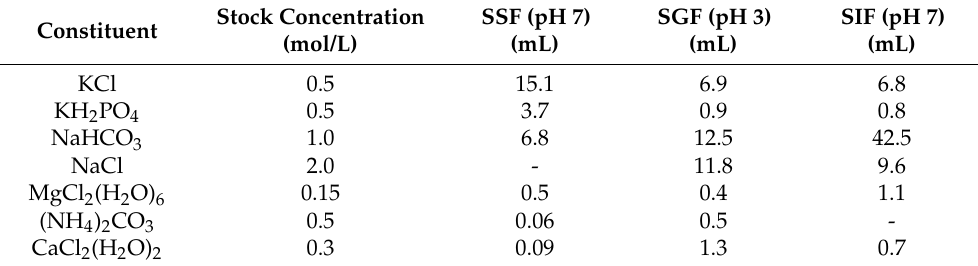
Table 1. Preparation of stock solutions of simulated digestion fluids. The volumes are calculated for a final volume of 500 mL for each simulated fluid.